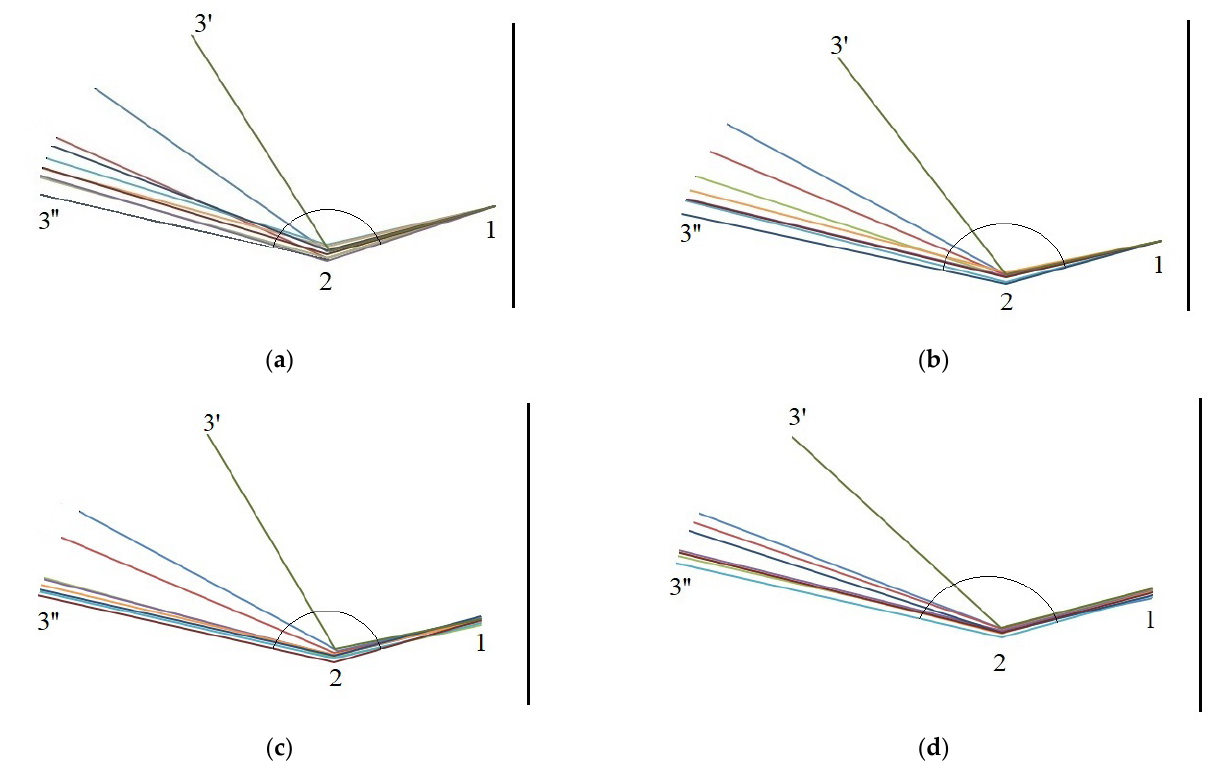
Figure 5. Changes in the opening angle of a scale from the middle cone segment at consecutive measurement times on ( a )—day 1, ( b )—day 2, ( c )—day 3, and ( d )—day 4(3 ′ —start day; 3 ′ ’—end day).